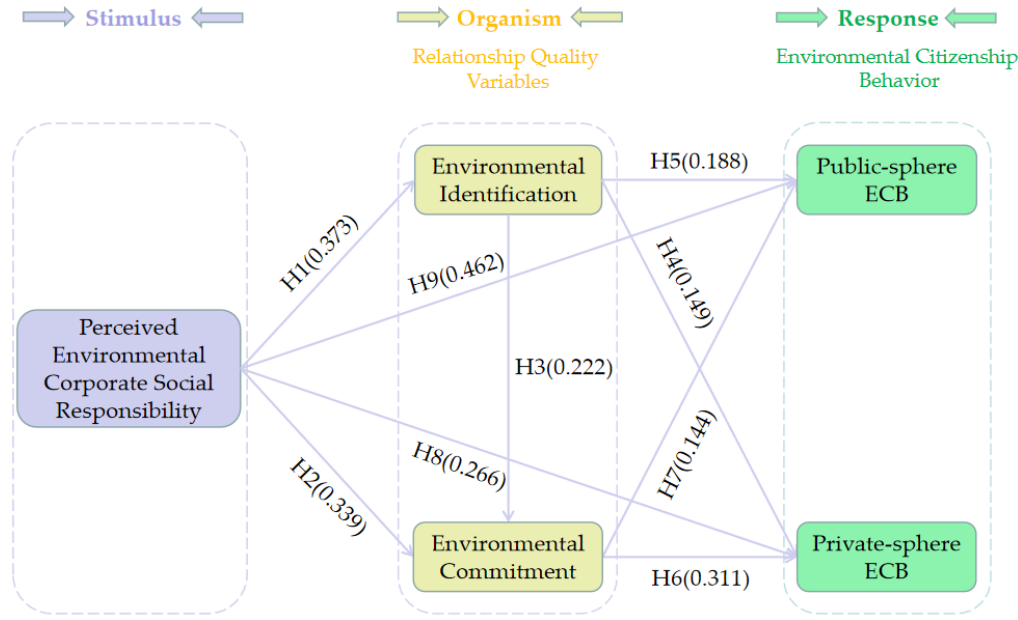
Figure 3. AMOS output results.